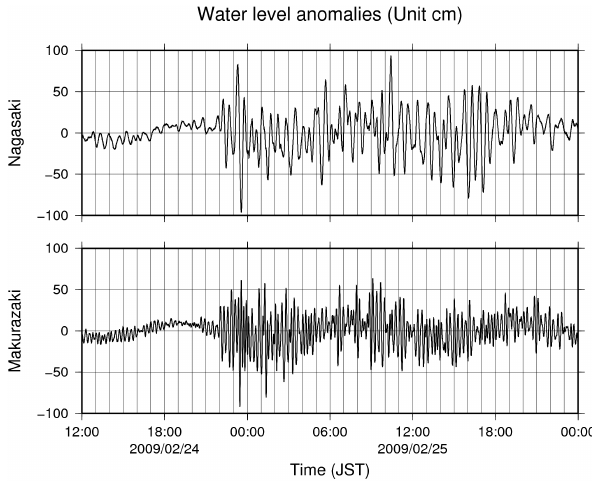
Fig. 2. Water-level anomalies observed at Nagasaki and Maku- razaki. Original data were provided by the Nagasaki Meteorological Bureau and the Japan Meteorological